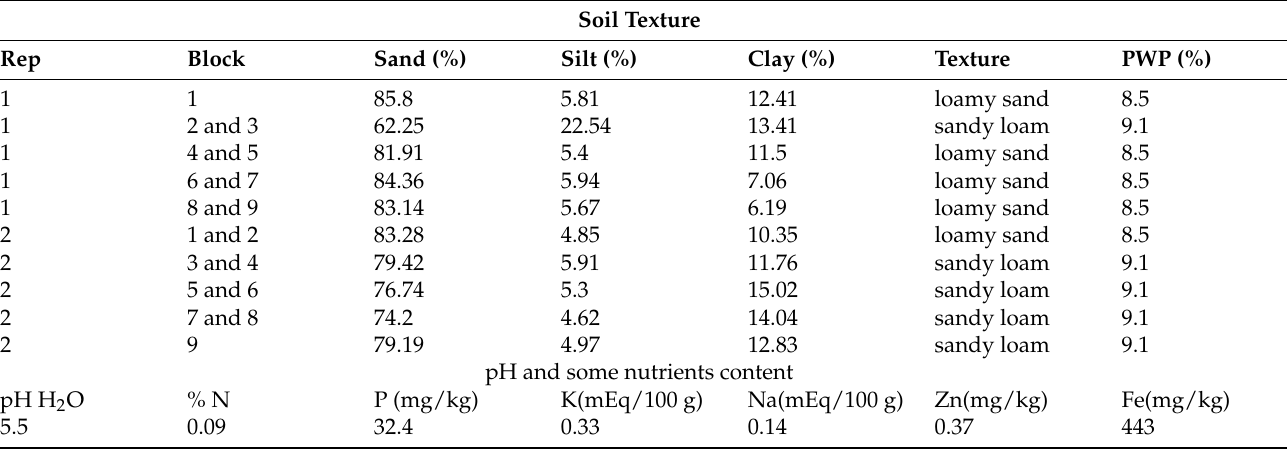
Table A1. Results of soil analysis for Gihanga site in Imbo Lowland.